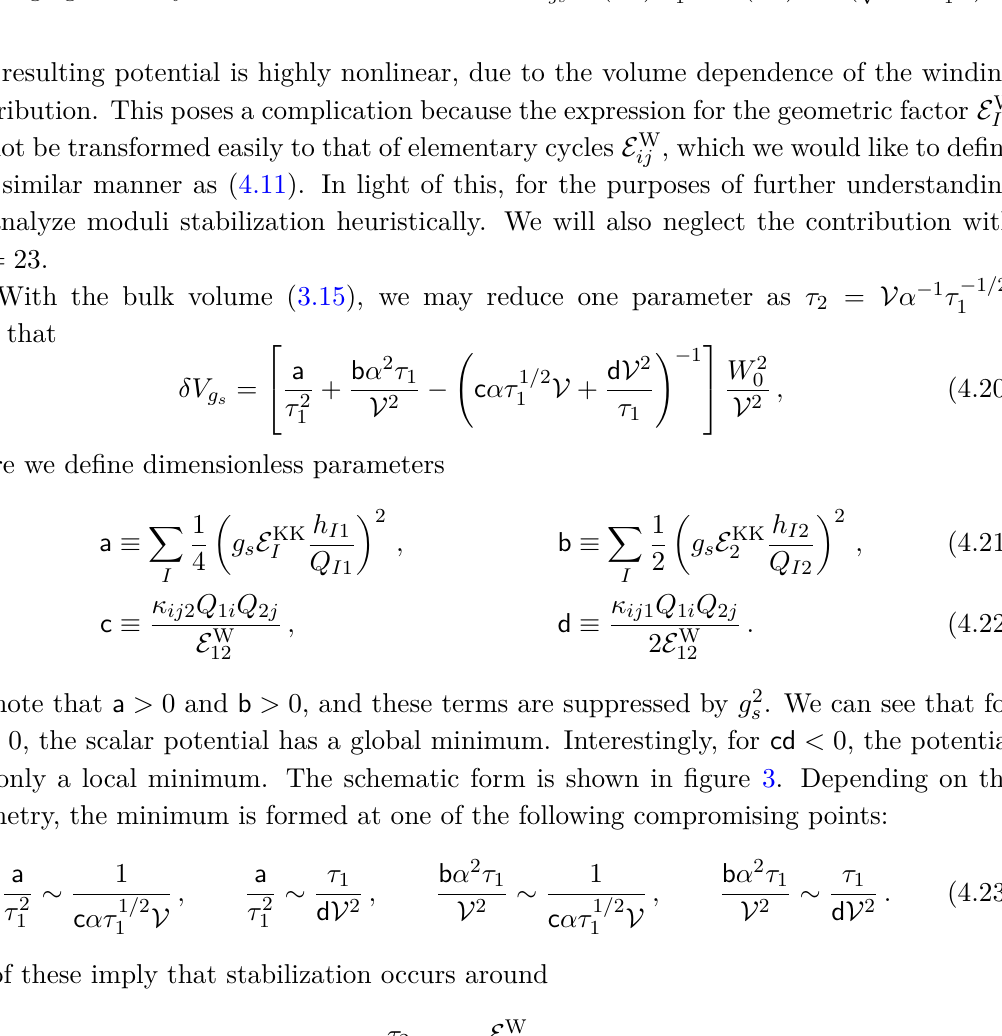
√ = (0 . 1) 2 τ − 2 +2 · (0 . 1) 2 τ 1 ± ( τ 1 ± 4 τ − 1 ) − 1 1 1 s